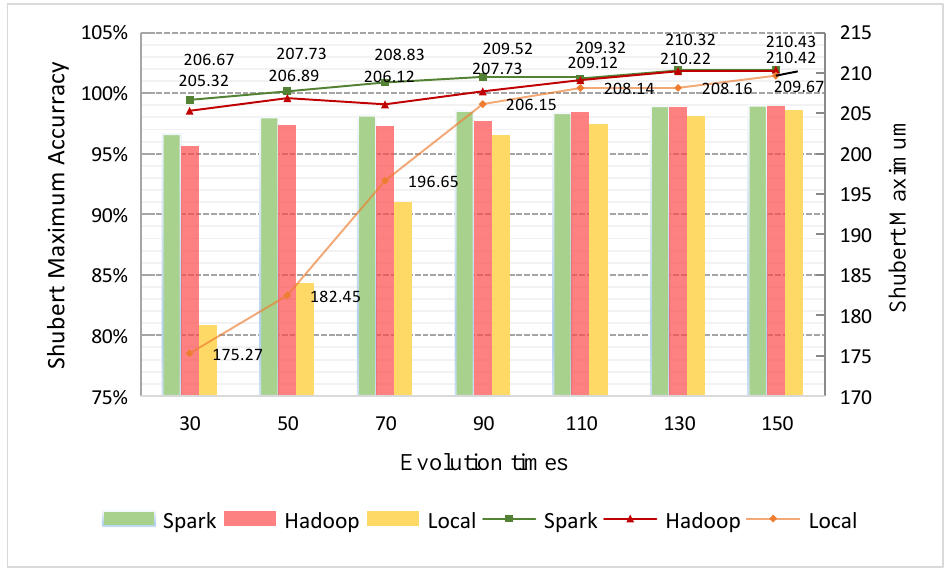
Figure 11. Solution accuracy comparison of GAESMPF.